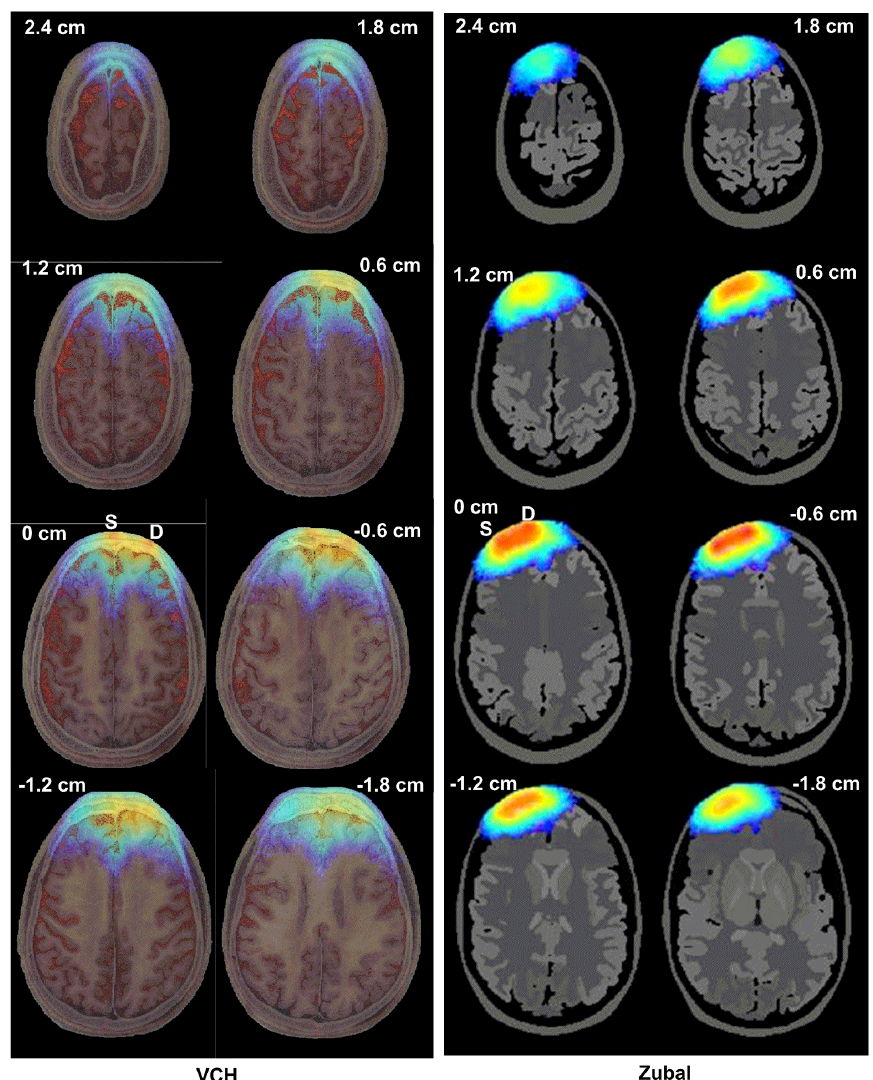
Fig. 3. SSD in VCH and Zubal head models, respectively. The separation of light source and detector is 3.7 cm.